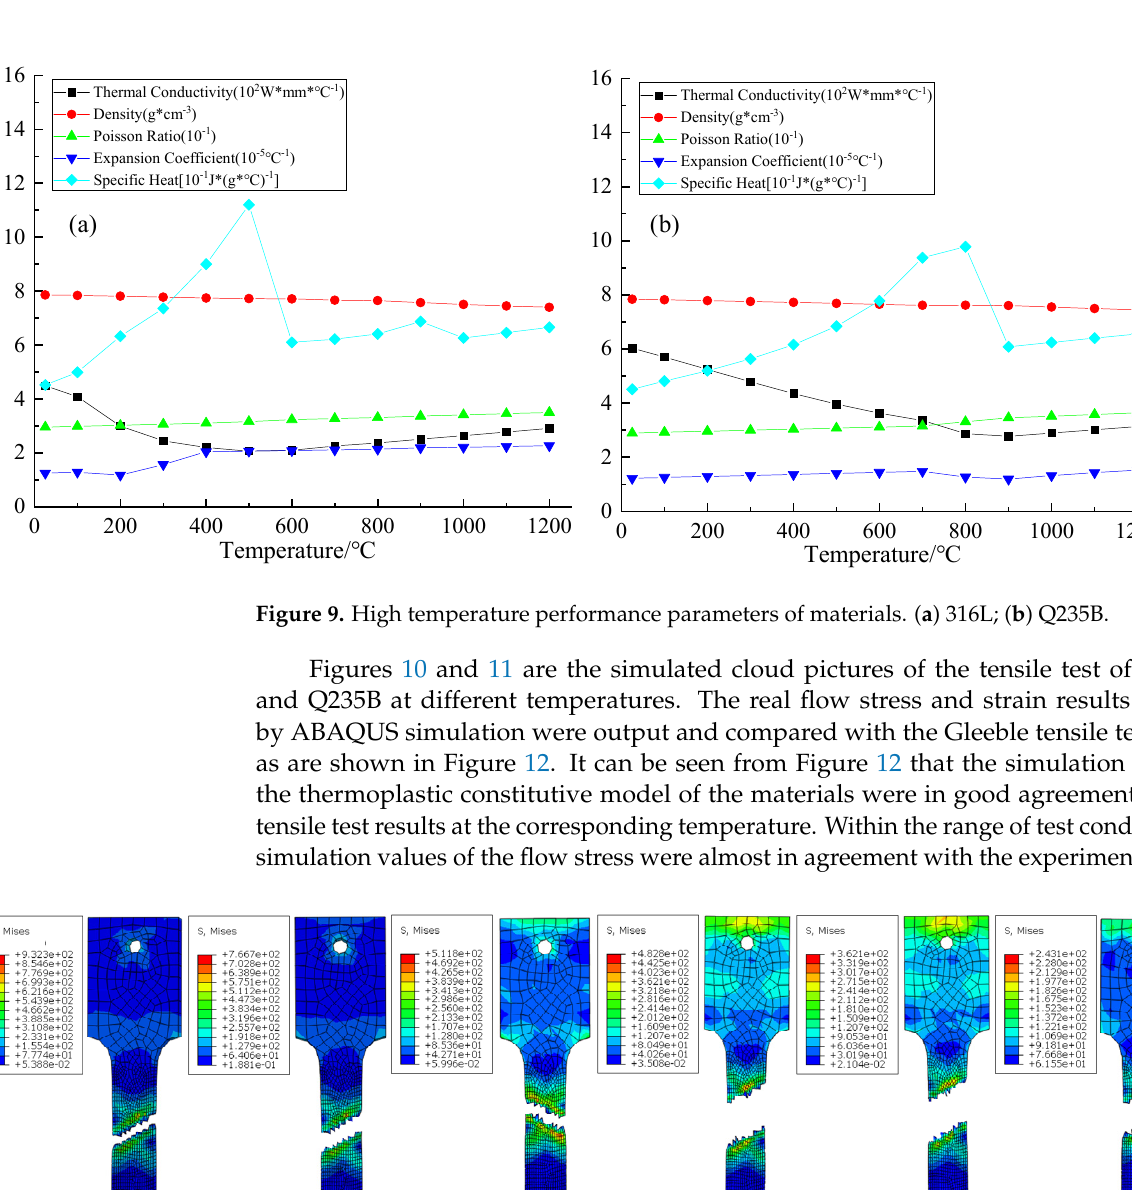
1000 ℃ Figure 11. Q235B high temperature tensile test simulation cloud diagram. Figure 12. Comparison of high temperature tensile test and simulation results of materials. ( a ) 316L; ( b ) Q235B. In order to describe the accuracy of the established thermoplastic constitutive model more accurately, the correlation coefficient R and the average relative error AARE are in- troduced [23]. 0.00